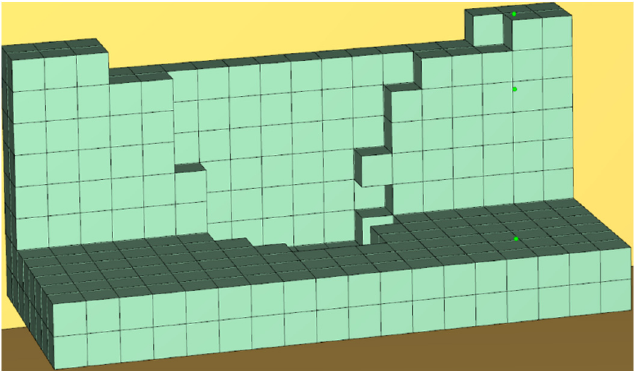
Figure 17. Material burnout in FDS simulation corresponding to phase E.